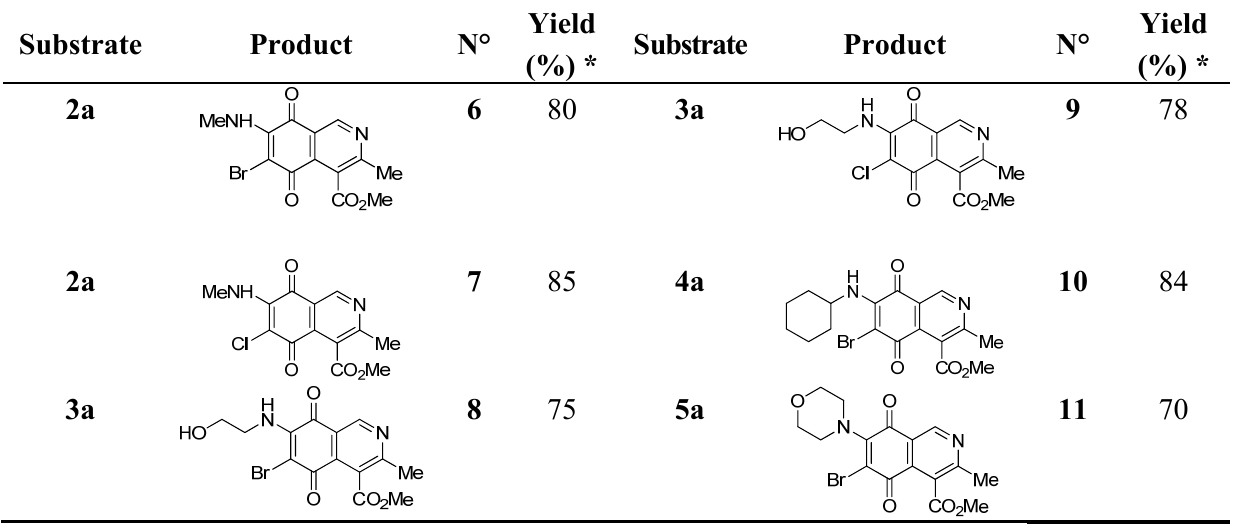
Table 1. Preparation of aminohaloisoquinolinequinones 6 – 11 .